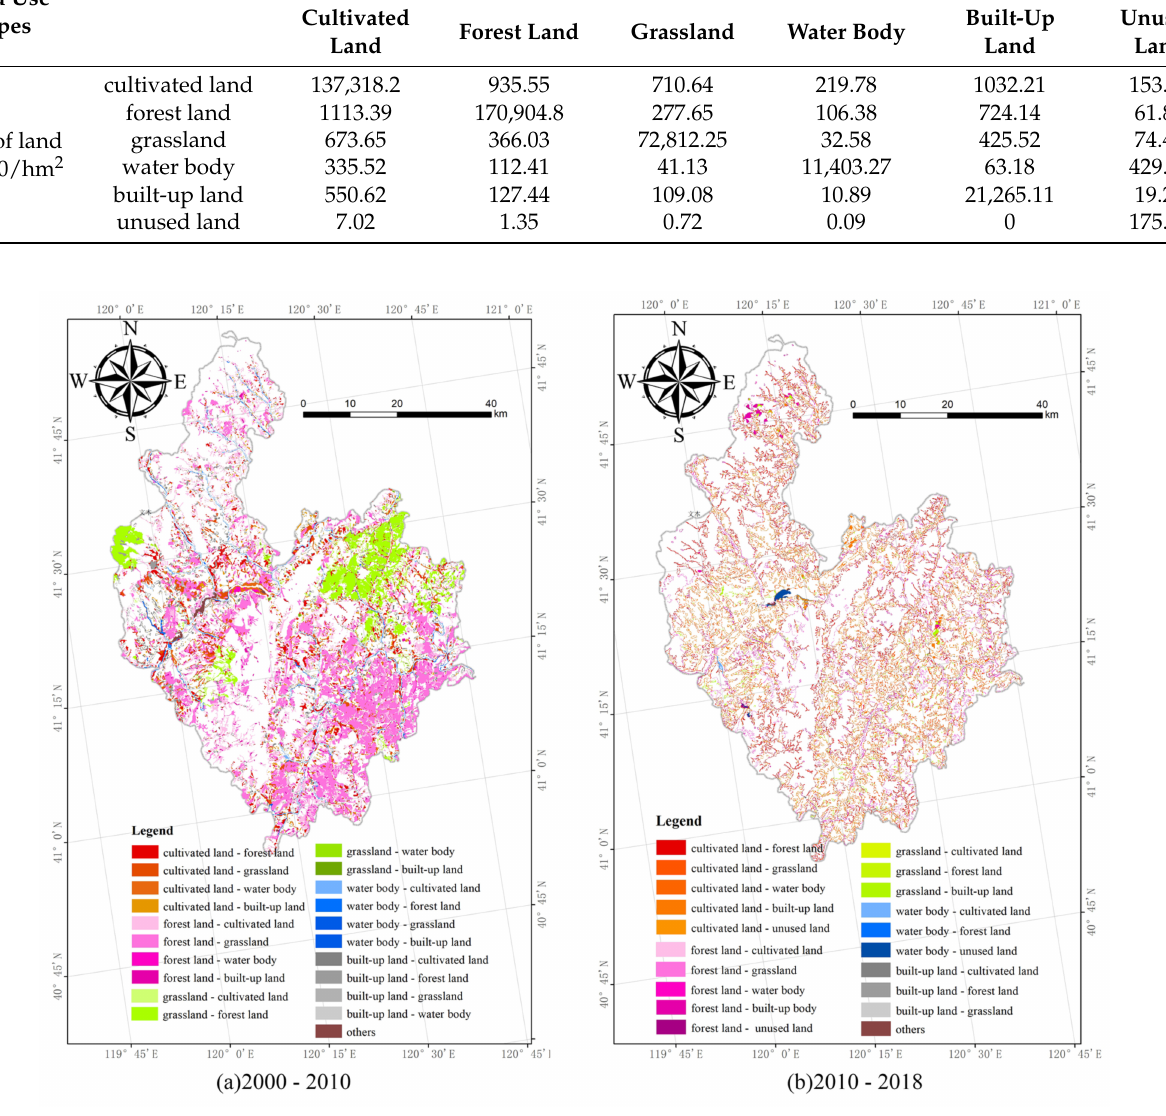
Figure 3. Land use transfer in Chaoyang County in ( a ) 2000–2010, ( b ) 2010–2018.